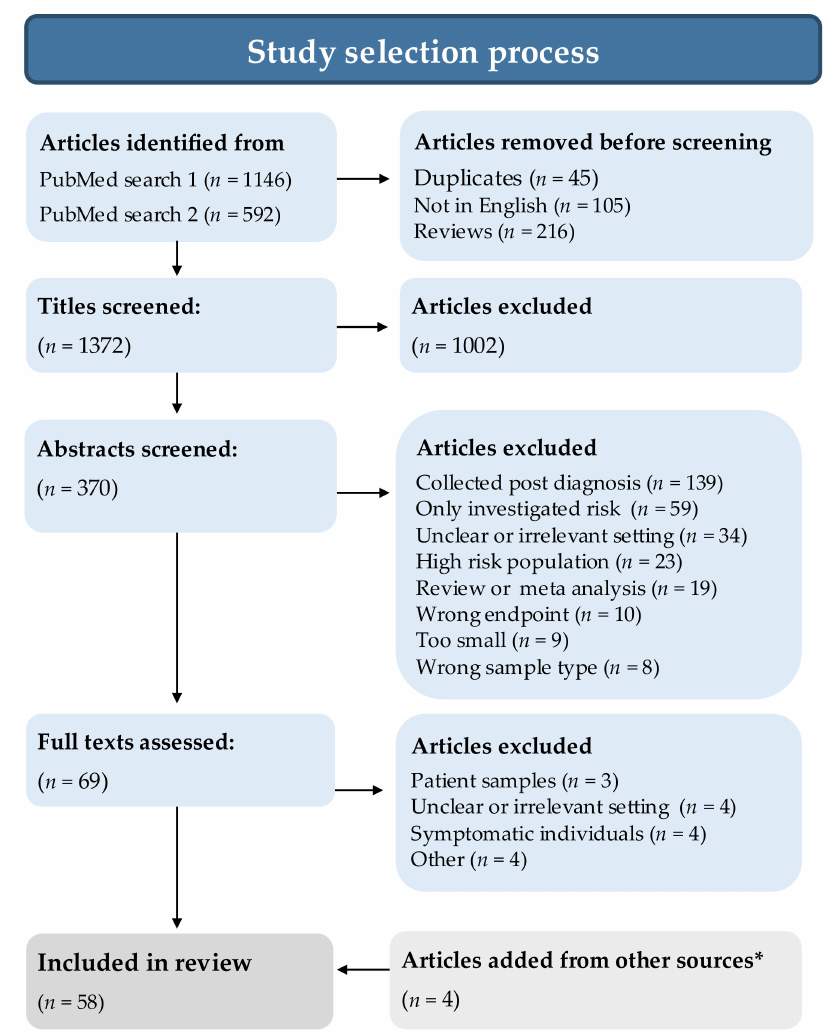
Figure 1. Flow diagram illustrating the selection of studies assessing blood-based risk-predictive and diagnostic biomarkers of colorectal cancer using pre-diagnostic samples from asymptomatic individuals, i.e., samples collected in prospective cohorts or general screening settings. During data extraction, an additional five studies were excluded due to lack of key information ( n = 1), too small sample size ( n = 2) or non-general screening population ( n = 2). * Other sources included reference lists, review articles, the article collections of the authors and post hoc searches of